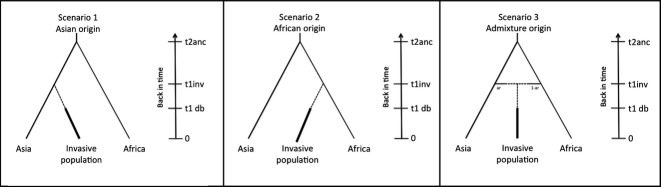
Graphical representation of the three scenarios of ancestral origin examined using approximate Bayesian computation implemented in diyabc. Scenario 1 corresponds to a direct ancestral origin from Asia, scenario 2 corresponds to a direct ancestral origin from Africa, and scenario 3 corresponds to an admixed origin from both Asia and Africa. In each case the black arrow indicates backwards steps in time in generations to when invasive populations were founded (t1inv generations ago), and then back in time to when the native populations diverged (t2anc). Duration of bottlenecks from founding events are included at t1 db. In scenario 3, the admixture rate (ar) represents the genetic contribution of the native populations.